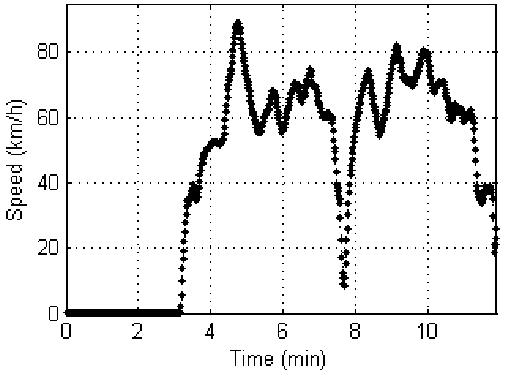
Figure 5. Doppler-based vehicle speed determination for a kinematic test drive.